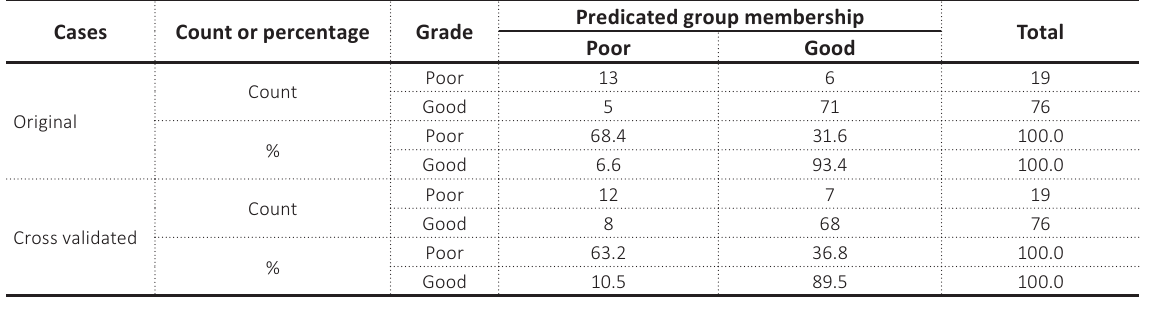
Table 6. Classification statistics results